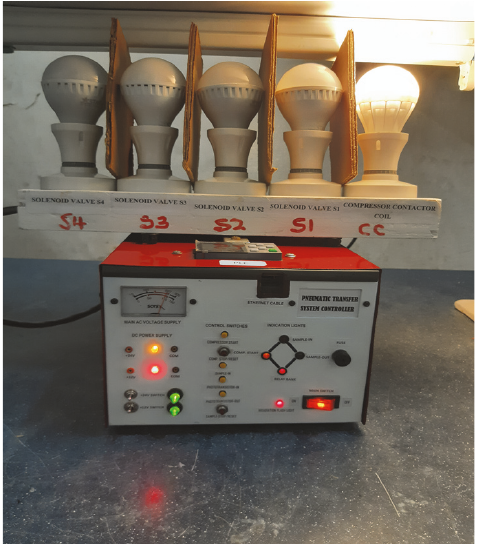
Figure 17: Solenoid valves S1 and S3 close, sample irradiation starts with flash light/beeps of buzzer.